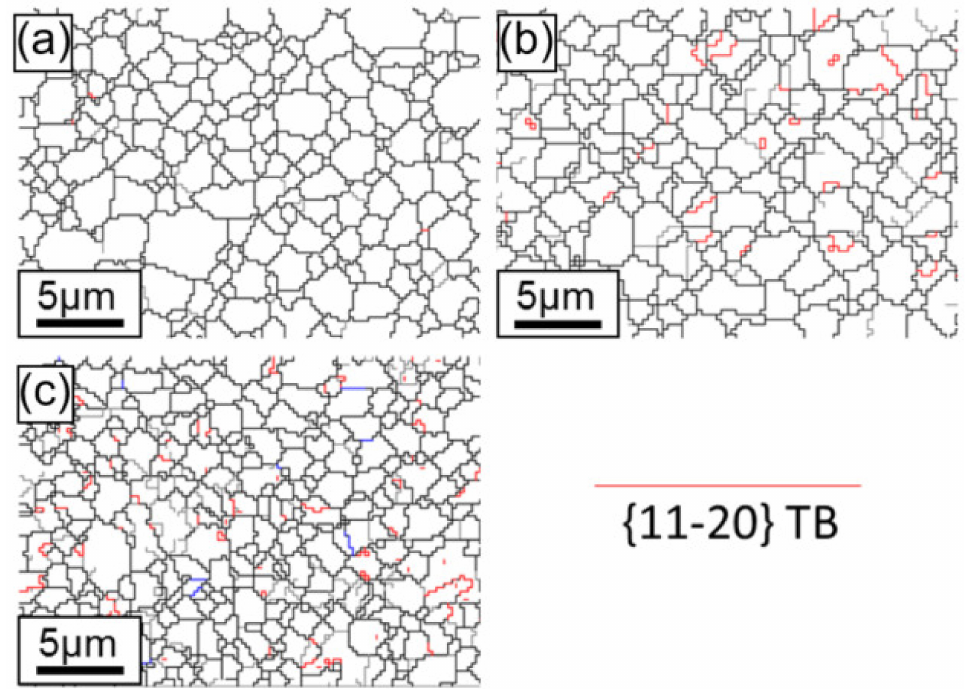
Figure 13. Twin boundaries in the WE43 core for the extension twinning {10-12} < − 1011 > mode distinguished in the maps with a red color as shown in the legend based upon the expected twin-parent relationships. ( a ) Initial undeformed state (0%), ( b ) compressive yield point (1.1%), and ( c ) compressive “ultimate” point